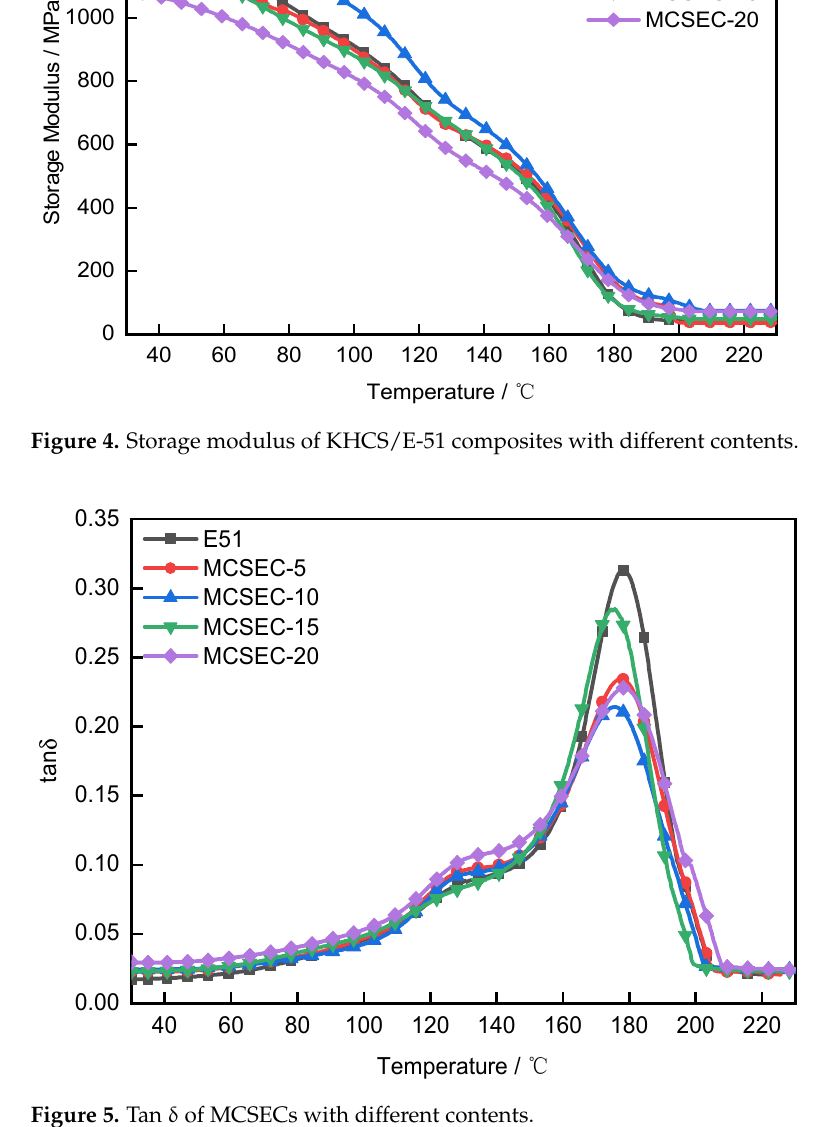
Figure 4. Storage modulus of KHCS/E-51 composites with different contents.